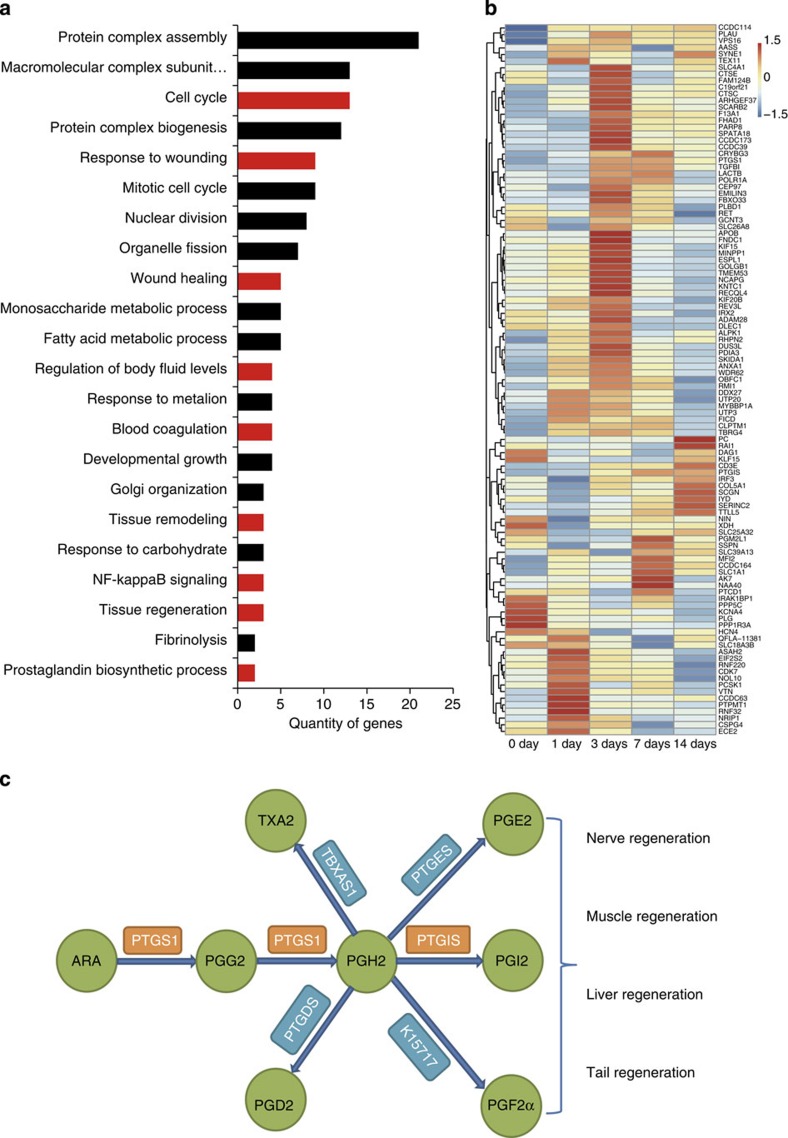
Positively selected genes (PSGs) related to tail regeneration in G. japonicus.(a) Analysis of 155 PSGs in G. japonicus based on representative gene ontology biological processes. Categories with red bars such as cell cycle (GO:0007049), response to wounding (GO:0009611), wound healing (GO:0042060), tissue regeneration (GO:0042246), tissue remodelling (GO:0048771), blood coagulation (GO:0007596) and prostaglandin biosynthetic process (GO:0001516) are likely to be involved in tail regeneration after autotomy. (b) Heatmap of 107 PSGs in G. japonicus at different time points following tail autotomy. Approximately 70% of the PSGs were detected in transcriptome data. (c) Pathway of arachidonic acid (ARA) metabolism in G. japonicus. The circles with green backgrounds represent ARA and its derivatives. The boxes with orange backgrounds show the key synthases under positive selection in G. japonicus genome. The boxes with blue backgrounds show the normal synthases in G. japonicus genome.